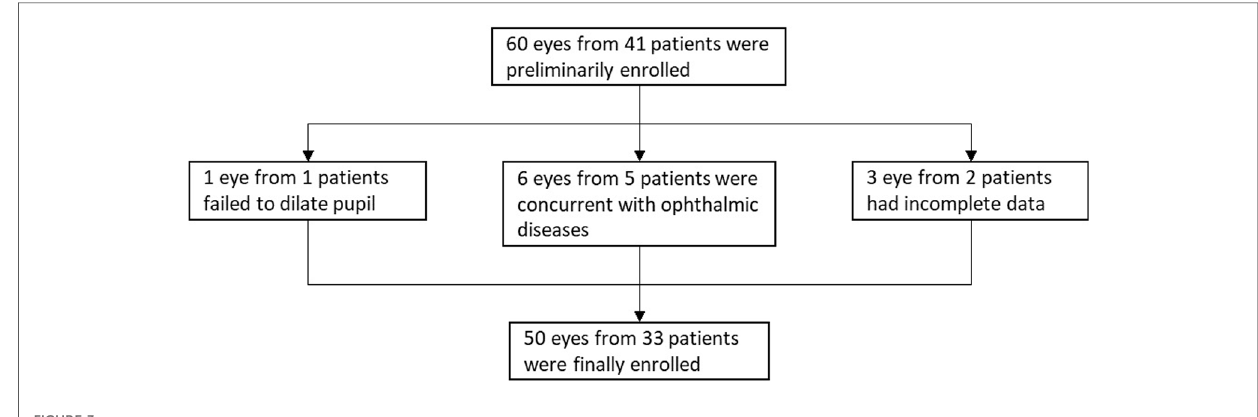
FIGURE 3 Detailed change in capsulotomy opening diameter (COD) between the two surgeries.